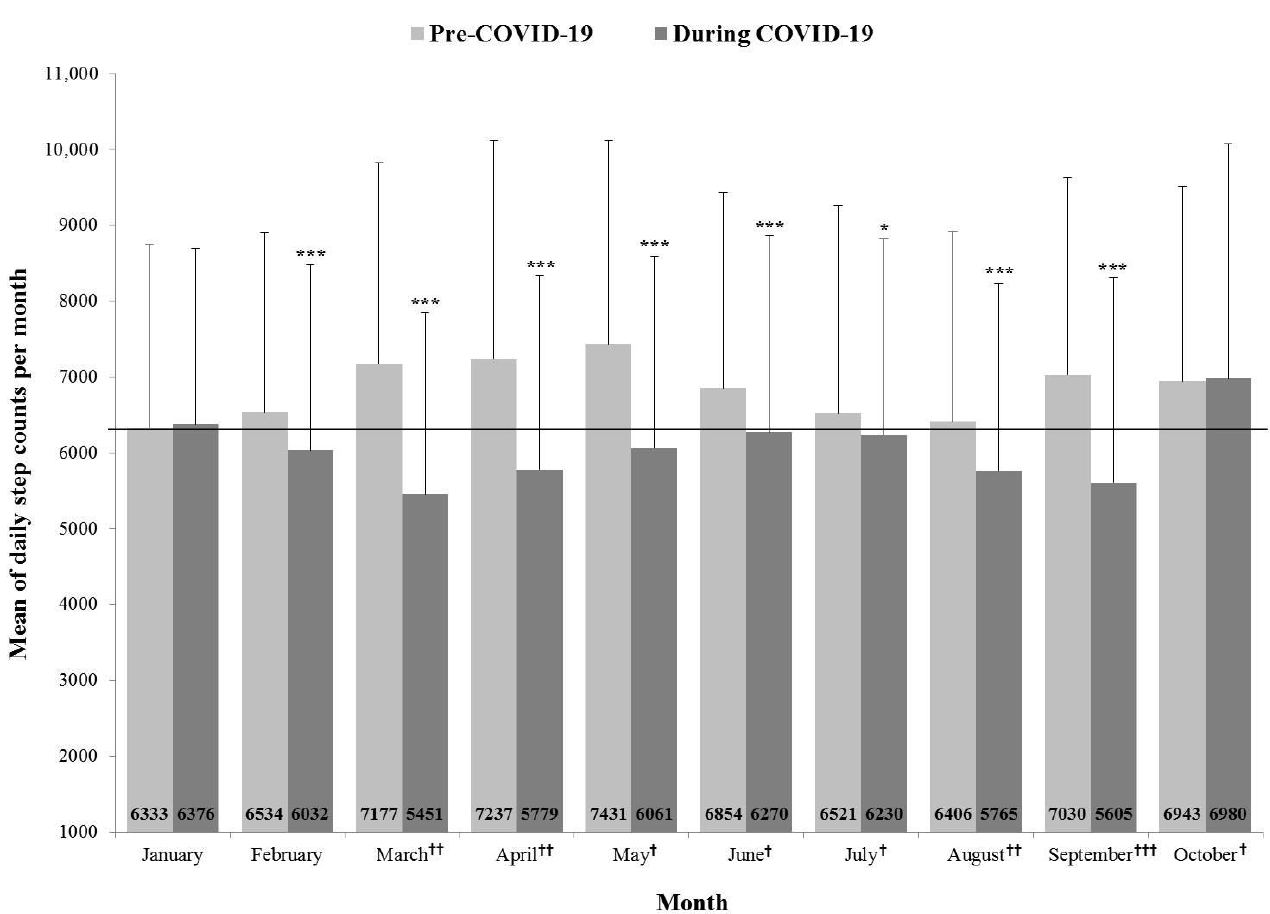
Figure 1. Mean of daily step counts per month before and during COVID-19. *** p < 0.001, * p < 0.05; †: Level 1 of social distancing in COVID-19, ††: Level 2 of social distancing in COVID-19, †††: Level 2.5 of social distancing in COVID-19.